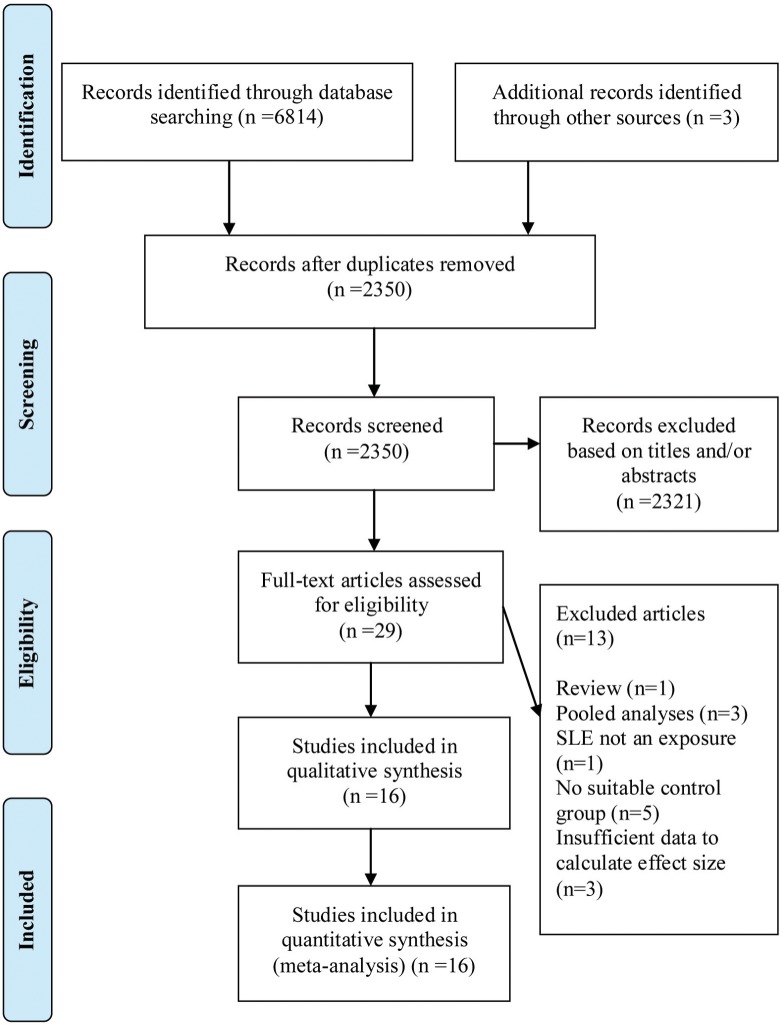
PRISMA Flow Diagram.